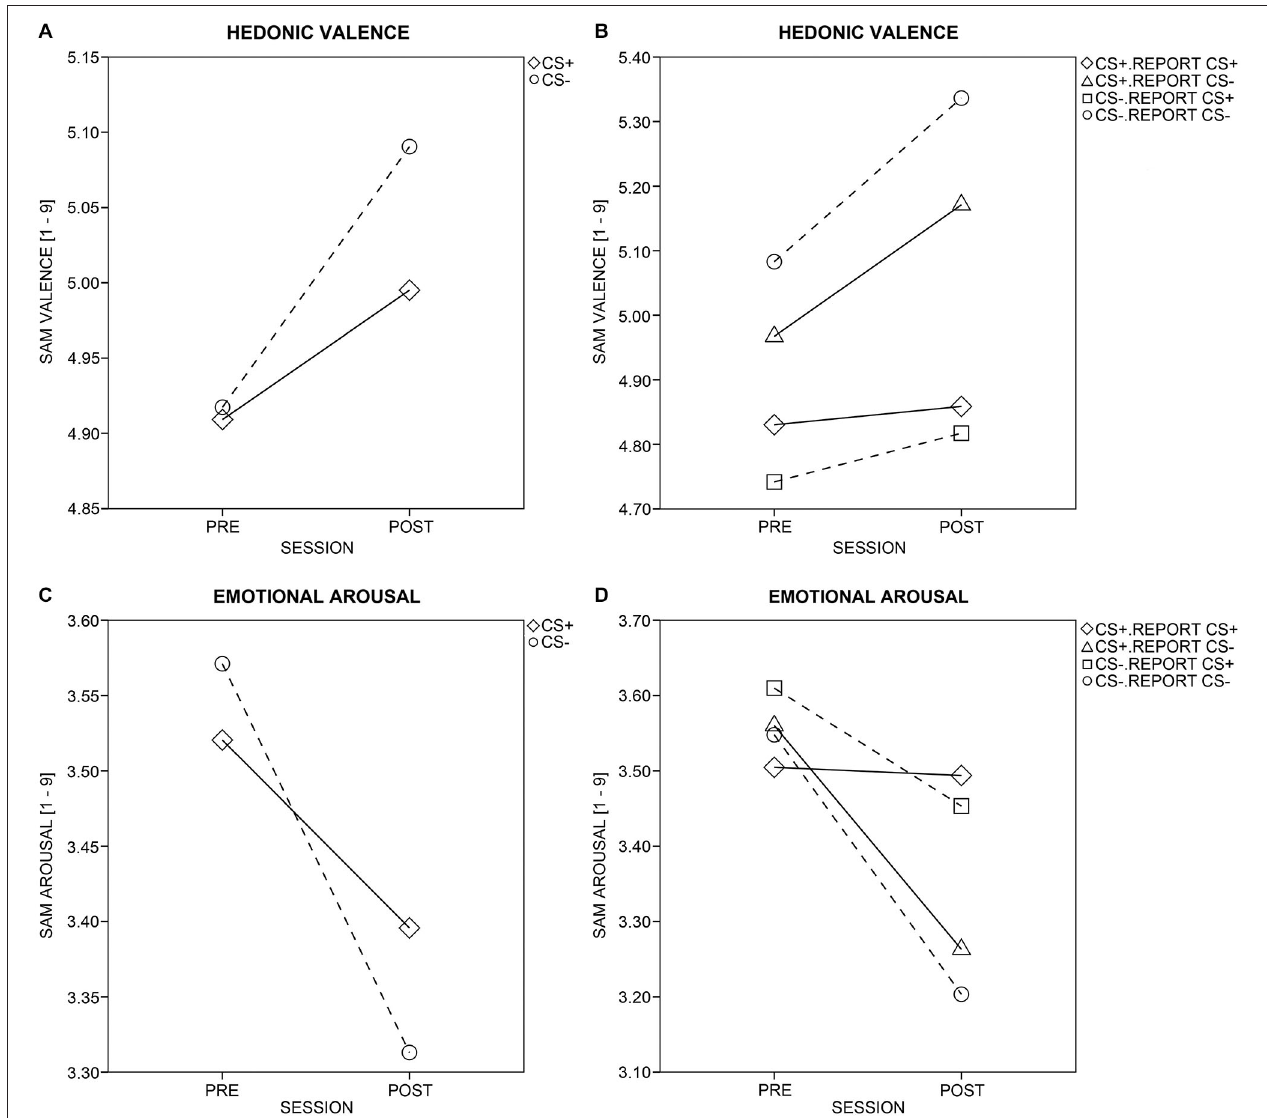
actual and perceived/reported pairing (as reported in the CS-US matching task). Solid and dotted lines mark CS+ or CS − , respectively. Diamonds and triangles show CS+, which were reported to be CS+ or CS − , respectively, while circles and rectangles mark CS − , which were reported to be CS − or CS+,